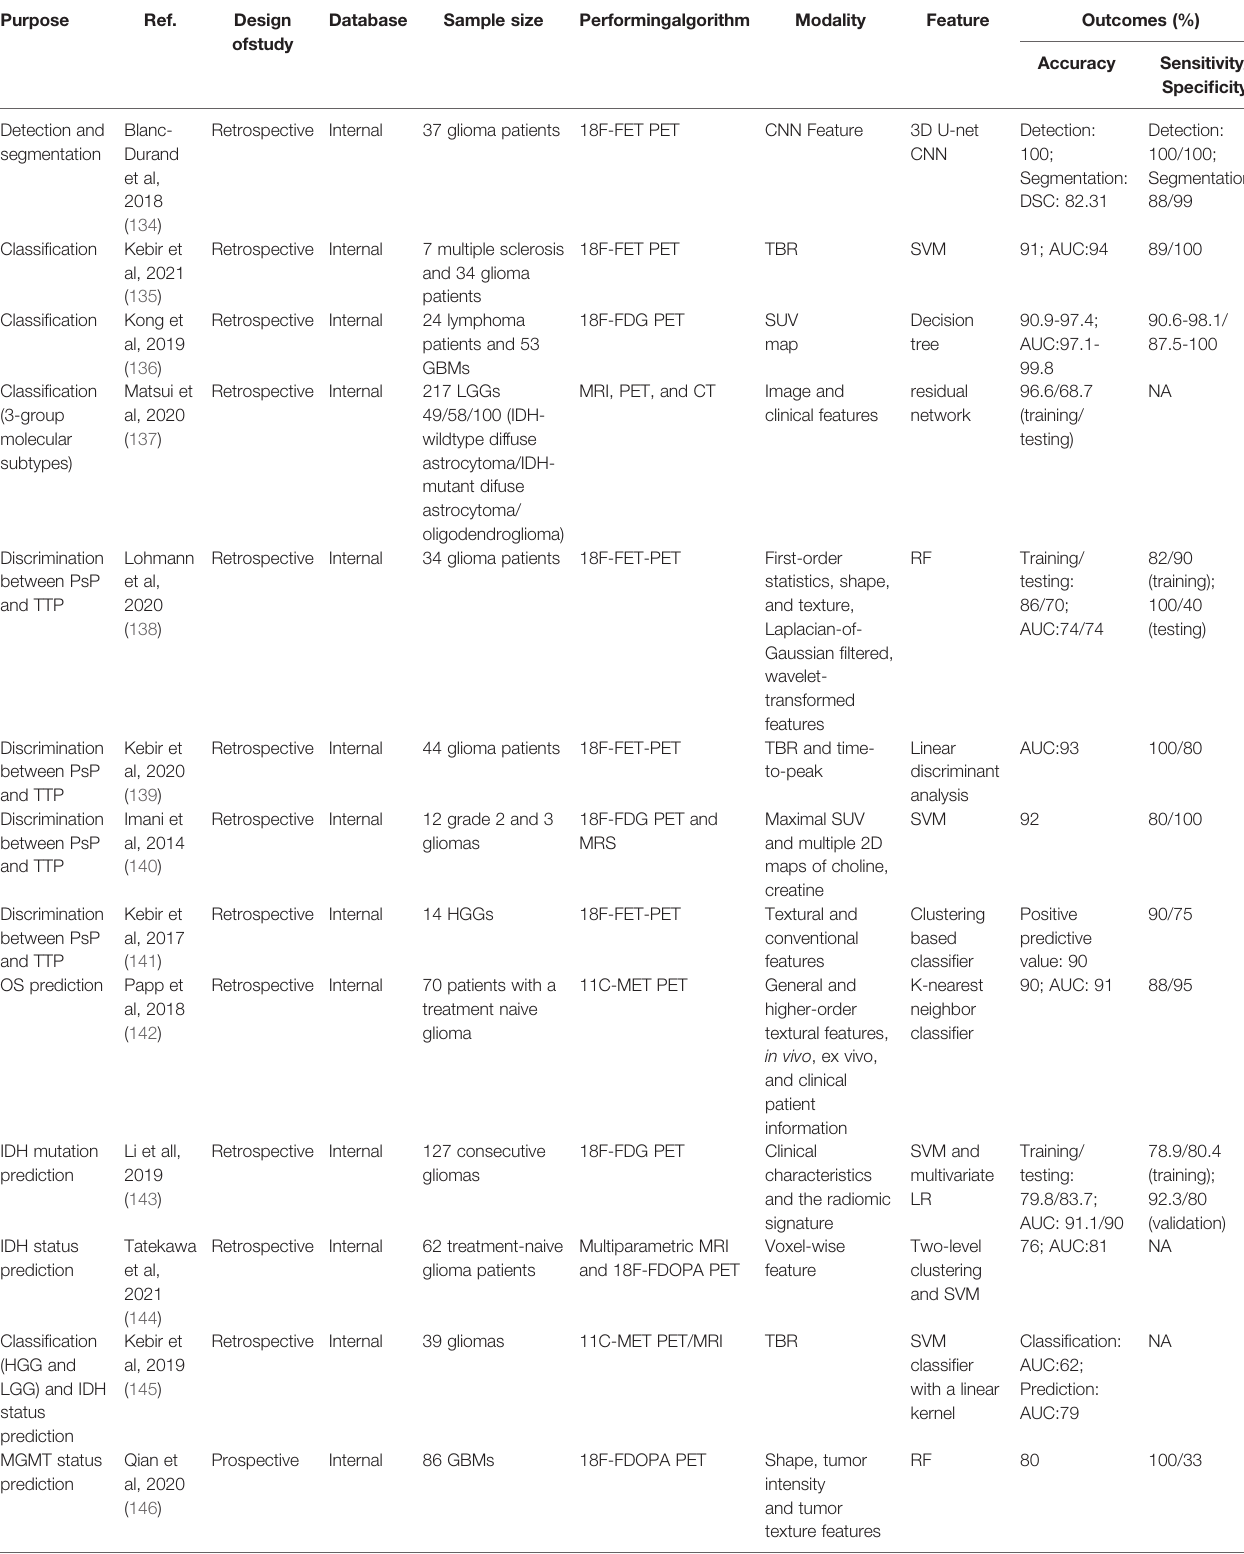
TABLE 1 | Summary of major studies on AI-assisted PET in Glioma.